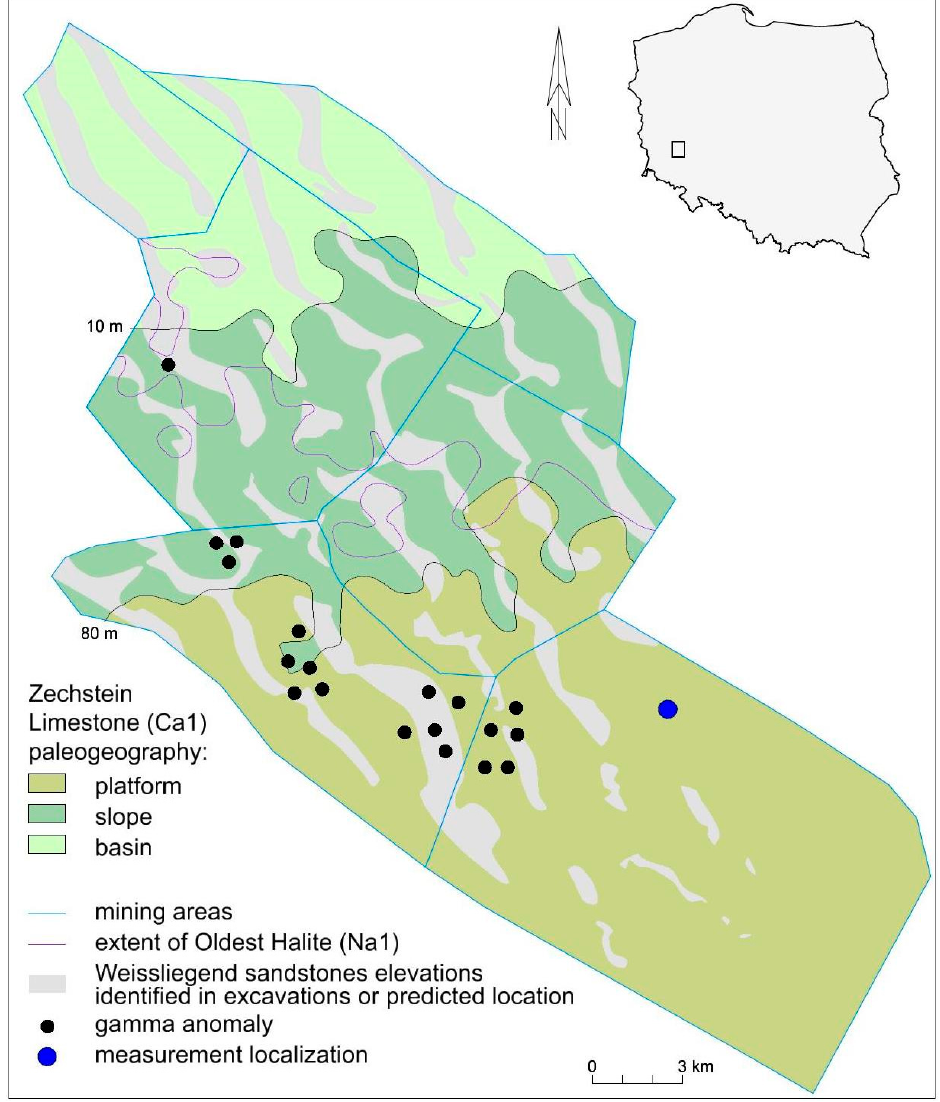
Figure 1. Measurement site on a geological background. Gamma anomalies were marked based on